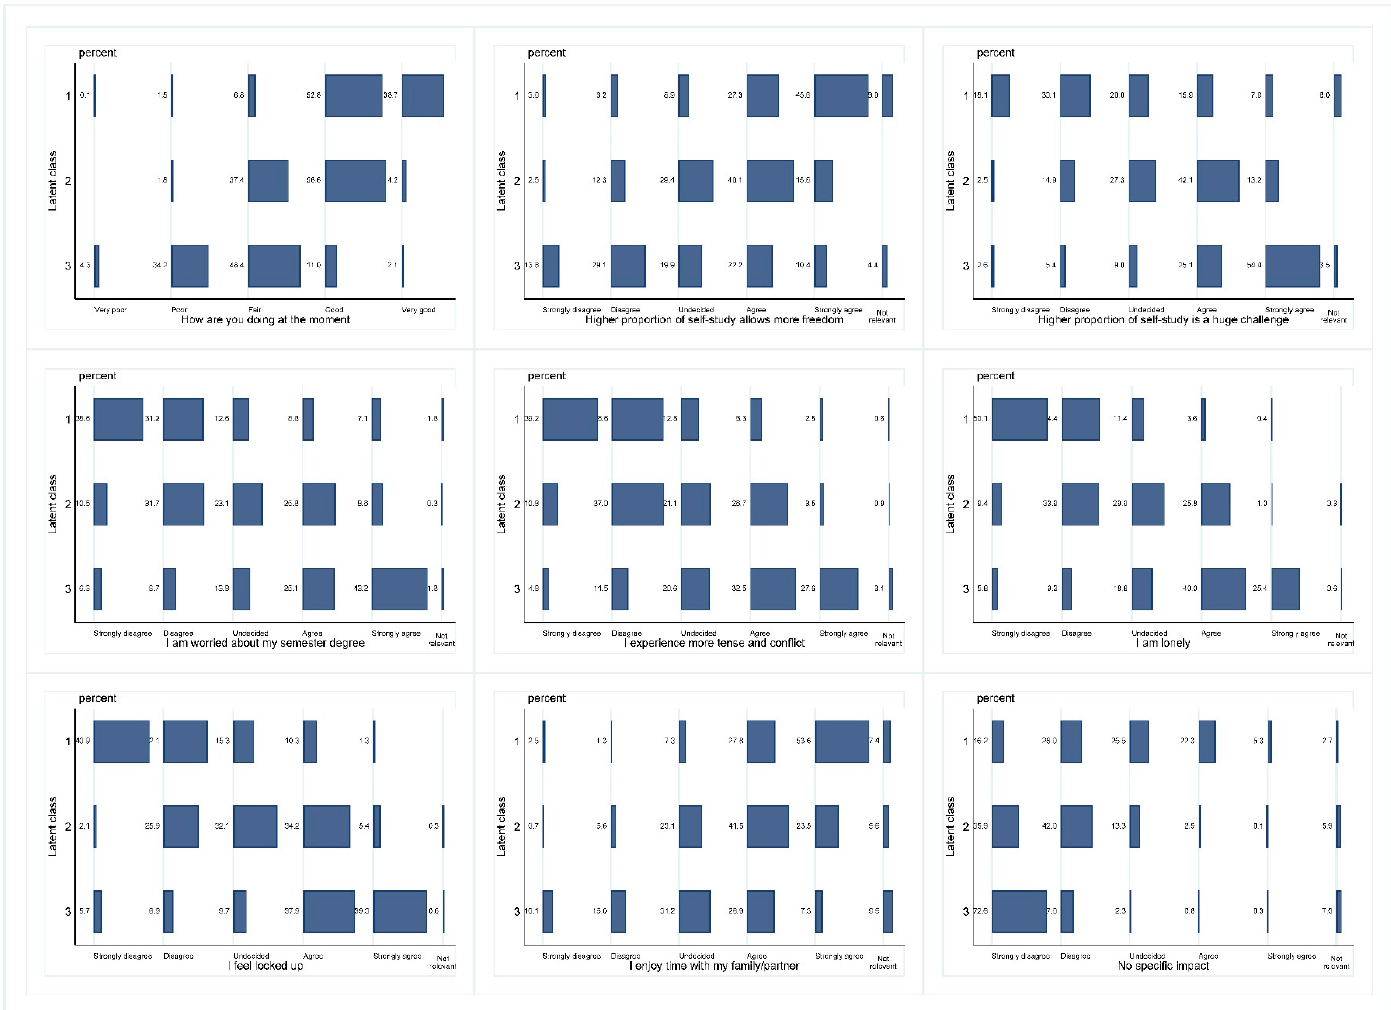
Figure 1. Latent class patterns. Legend: N = 2 ′ 429; Latent class 1 = low; 2 = moderate, 3 = high impact on wellbeing and daily life, based on latent class analysis.